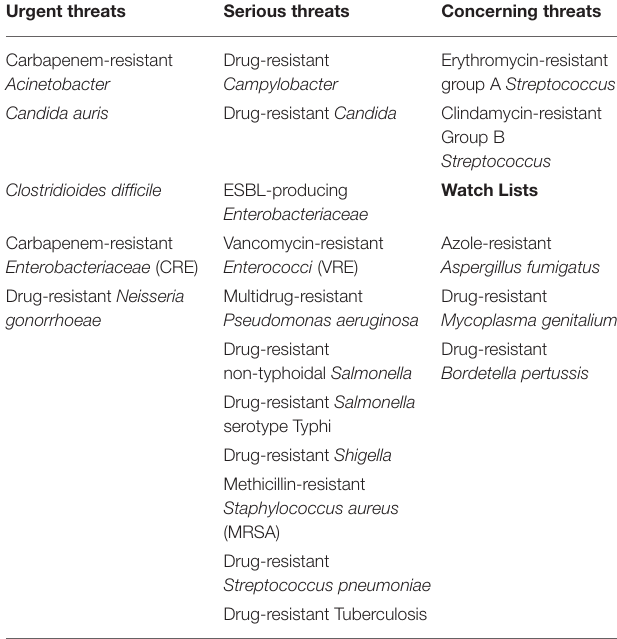
TABLE 4 | CDC threats to public